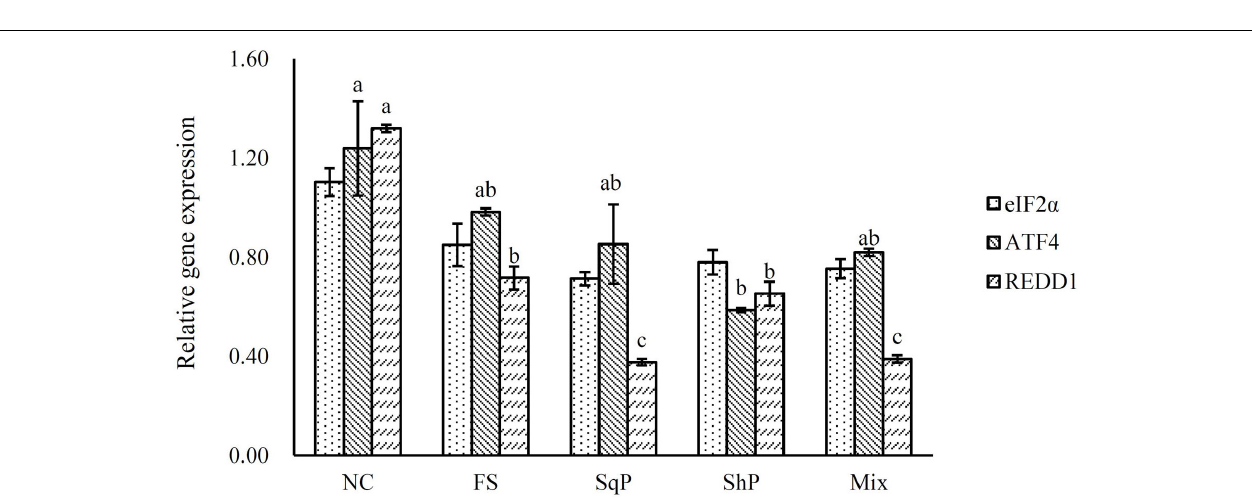
FIGURE 2 | The expression of TOR pathway-related genes, target of rapamycin (TOR), protein kinase B (AKT) 1, and ribosomal protein S6 (S6) of largemouth bass fed the experimental diets for 81 days. Values (means ± standard error of the mean, SEM) in bars that have the same letter are not significantly different ( P > 0.05; Tukey’s test) among treatments ( N = 3).